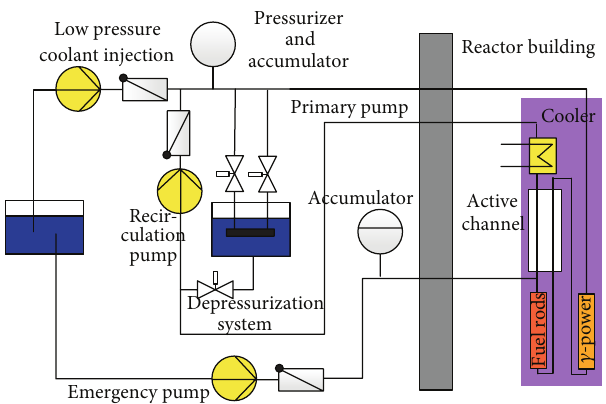
Figure 2: Schematic diagram of the primary loop and of the safety system for the SCWR fuel qualification